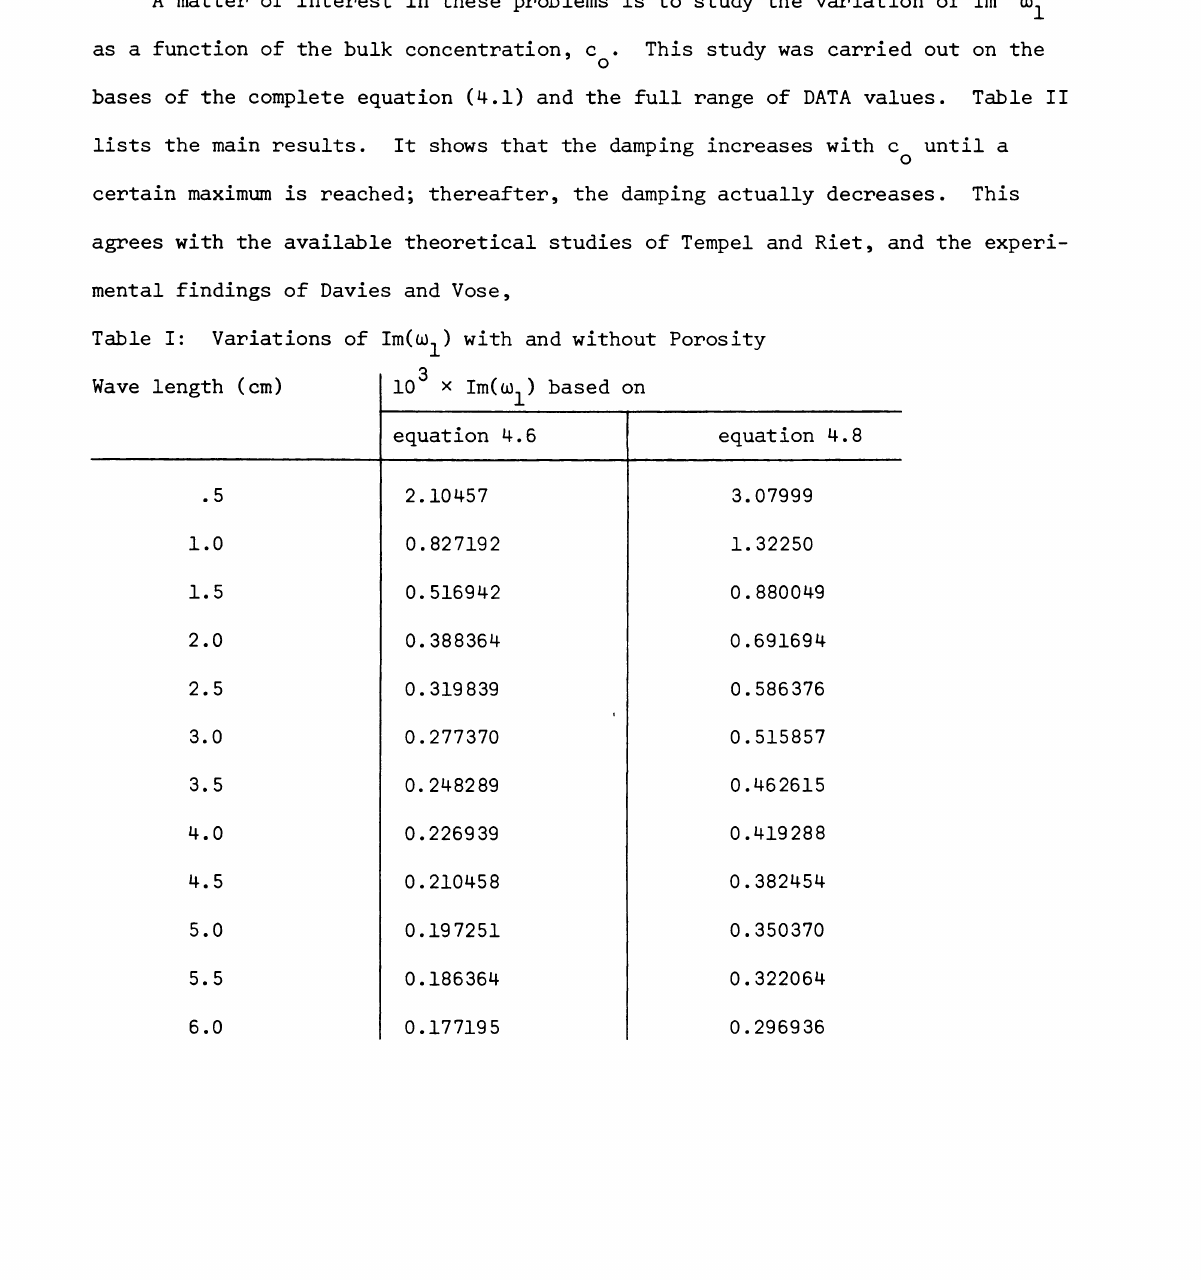
Variations of Im( I) with and without Porosity Wave length